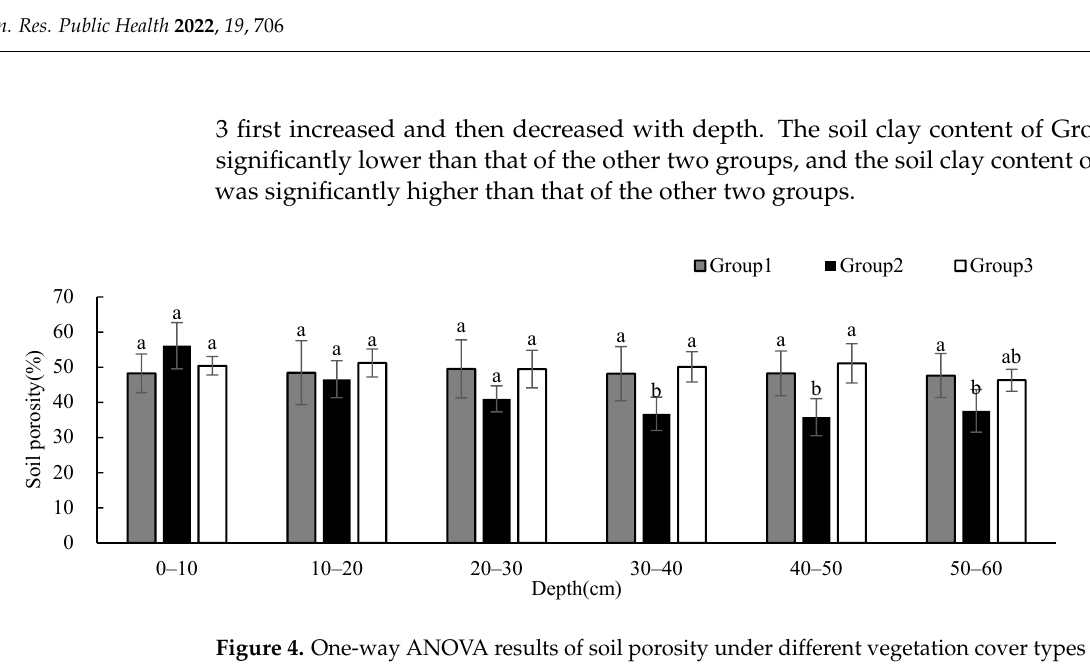
Figure 4. One-way ANOVA results of soil porosity under different vegetation cover types at different depths ( p < 0.05; a > b).